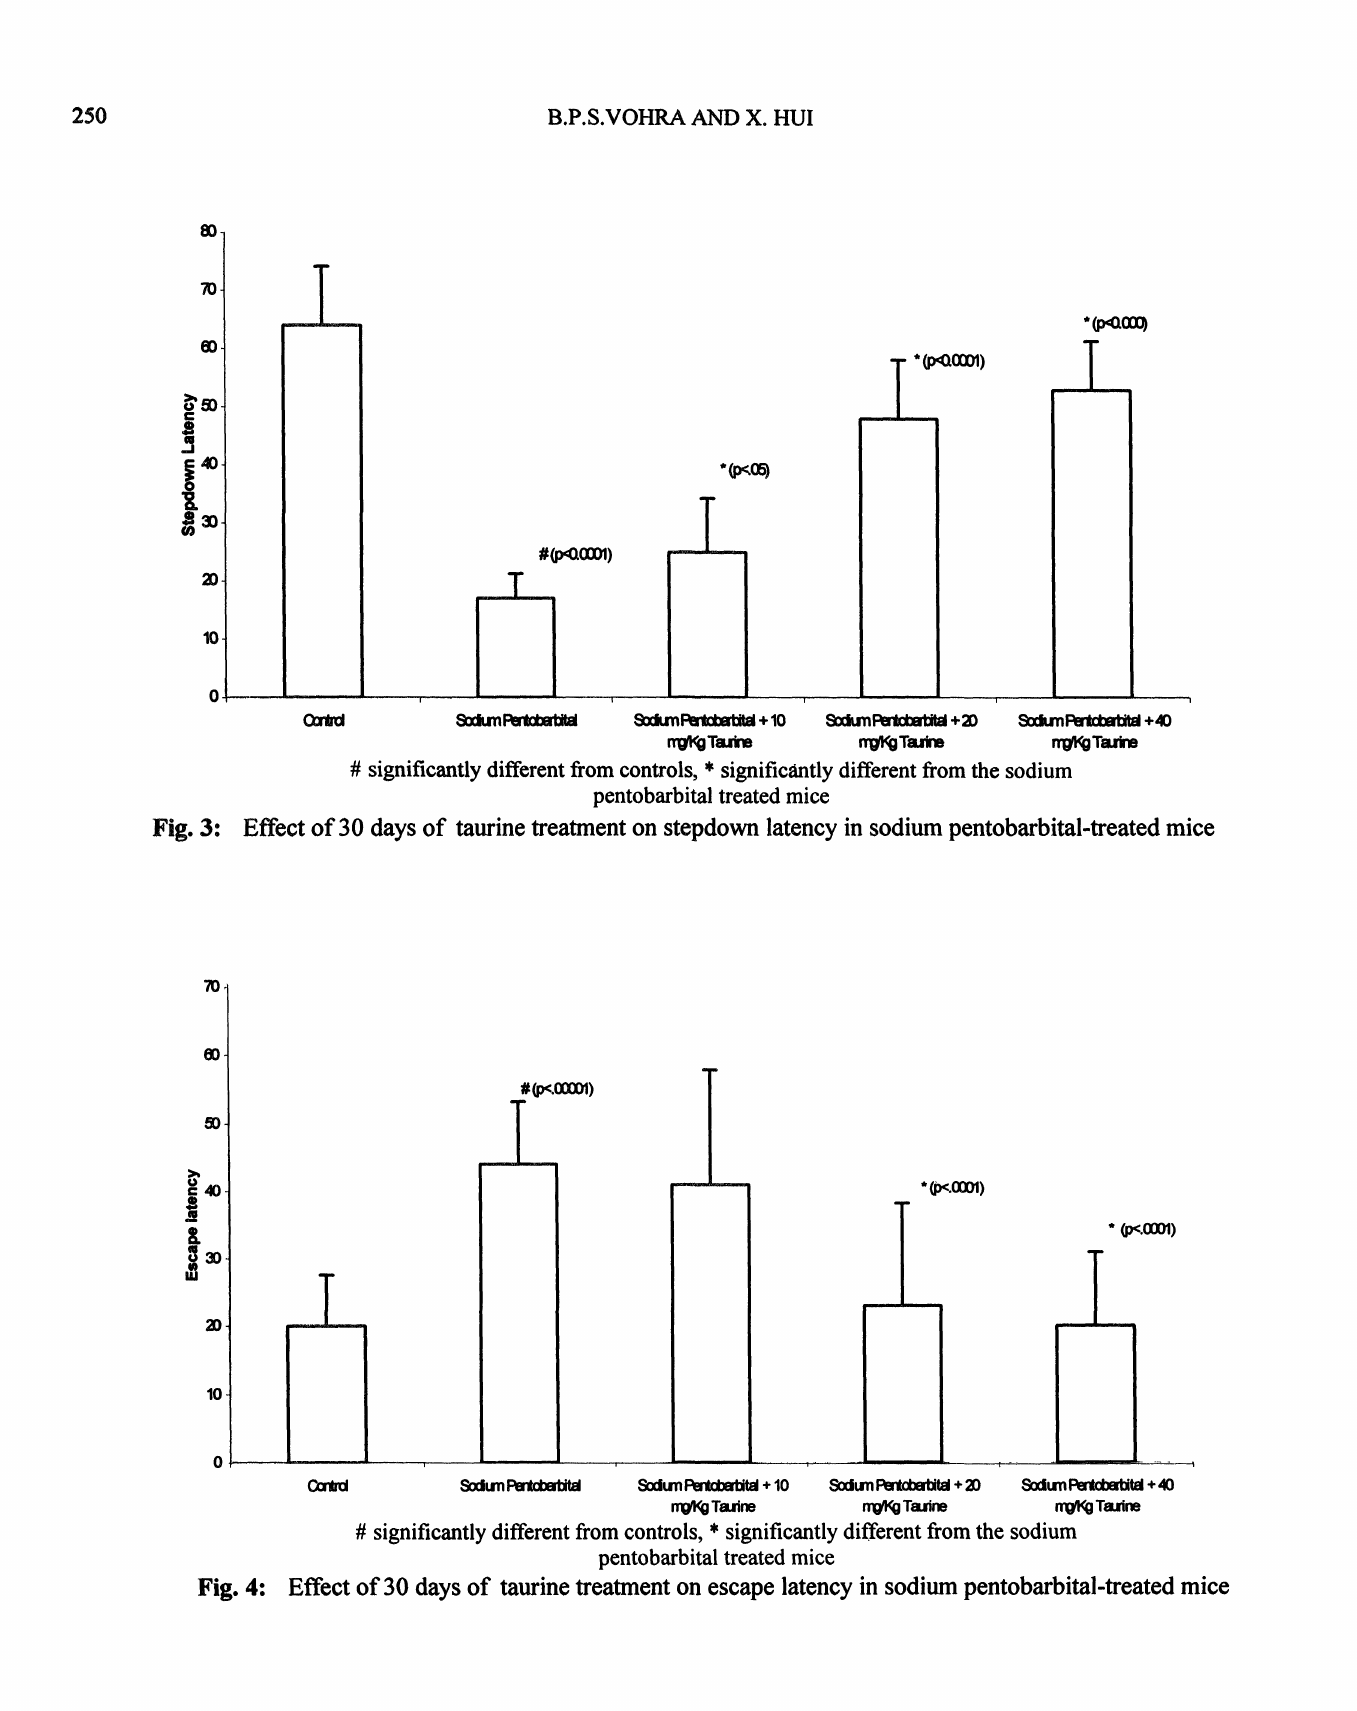
Sodun Sodt tal 10 $odtn Pentdital 0 $odwn t=ntdddtd 40 rr Taine n’g Tauine # significantly different from controls, * significantly different from the sodium pentobarbital treated mice Effect of 30 days of taurine treatment on escape latency in sodium pentobarbital-treated Fig. 4: